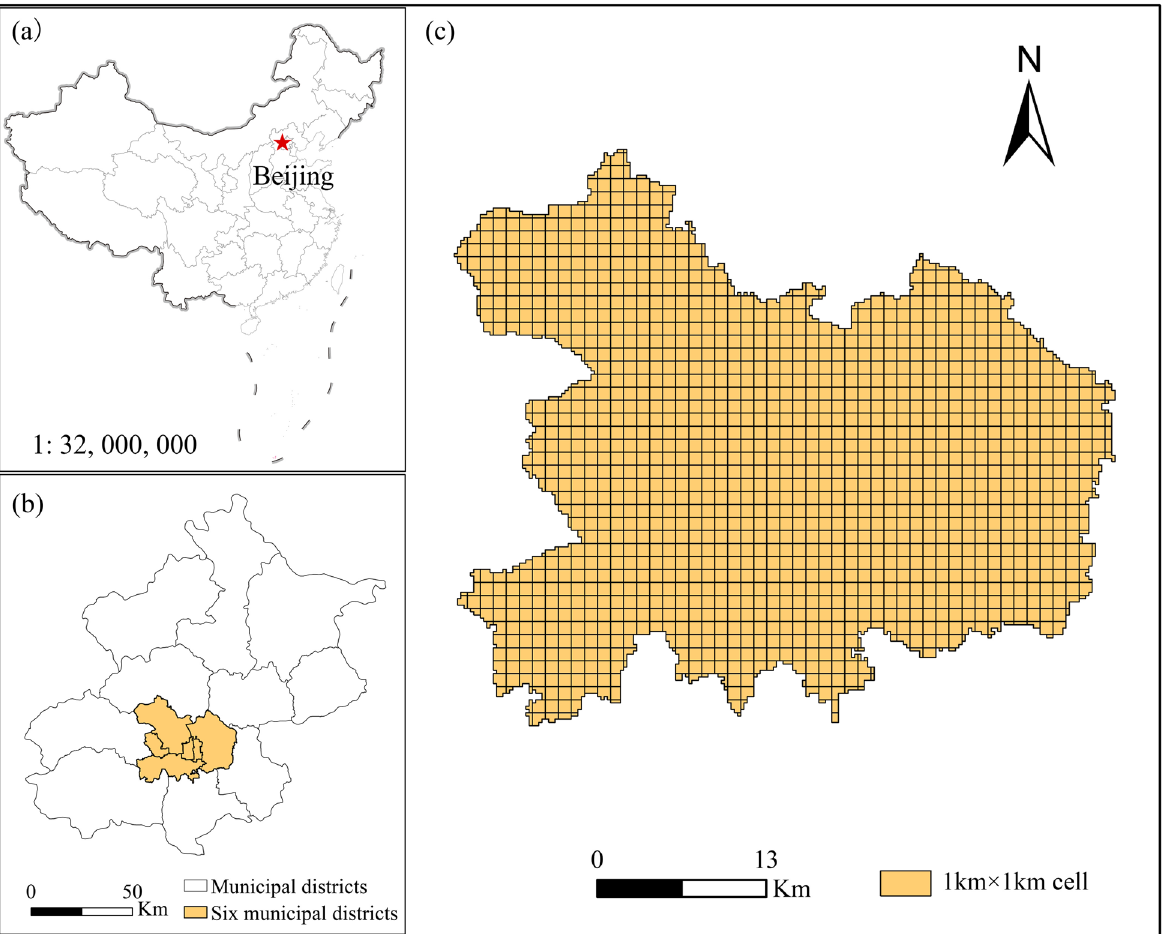
Fig. 1 a Location of Beijing in China; b Location of the study area in Beijing; c Study area (the six central municipal districts of Beijing) and unit (1 km 1 km grid cell) ×